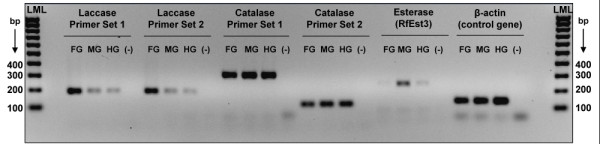
Laccase, catalase, RfEst3 esterase, and β actin (as a control) gene expression in Reticulitermes flavipes worker guts as determined from 35 cycles of conventional polymerase chain reaction (PCR) amplification. Shown is a negative image of a representative agarose gel with equal loadings of PCR products for the four genes. Lane labels are as follows: FG, foregut plus salivary gland; MG, midgut; HG, hindgut; and (-), no template control. Two primer sets were tested for the laccase and catalase genes, and one primer set for esterase and β actin. A 100 base pair (bp) low molecular weight ladder (LML) is shown at the left and right. See Additional file 9 for PCR primer sequences.